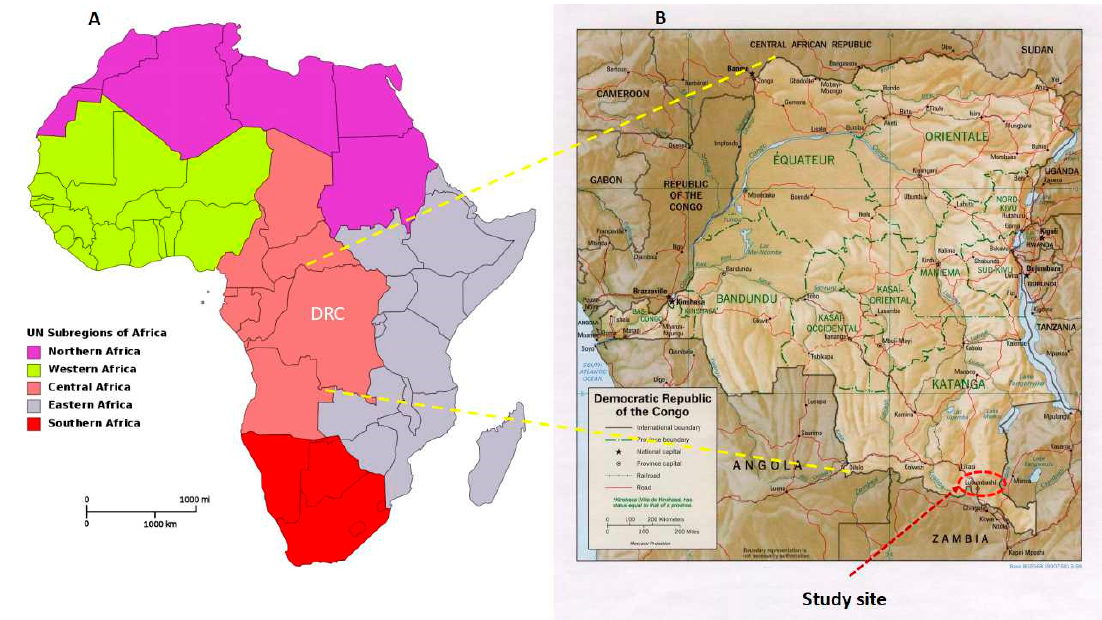
Figure 1. Map of Africa ( A ) and the Democratic Republic of Congo ( B ) with study sites located in Lubumbashi, southern province of Haut-Katanga, in the Democratic Republic of Congo (source of maps: Wikimedia commons).